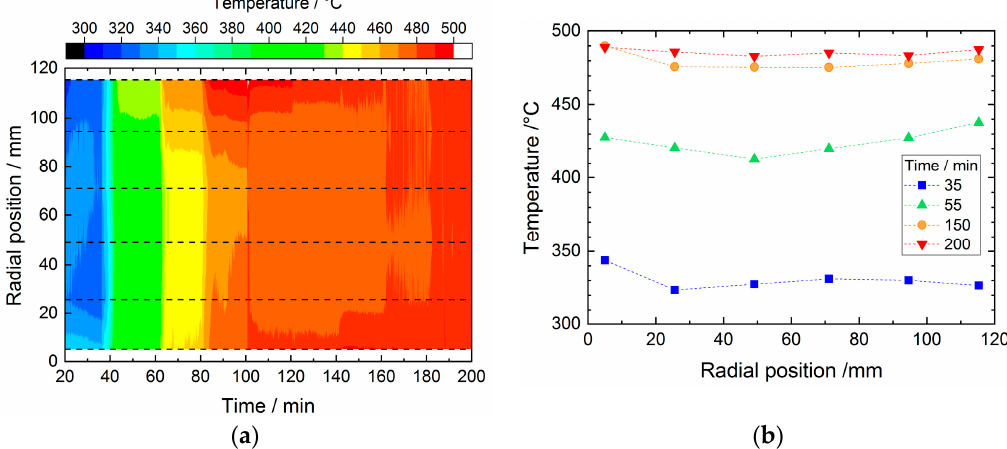
Figure 5. ( a ) Contour plot of the temporal progress of the temperatures in the exhaust-gas diffusor; ( b ) Radial temperature distributions extracted from the contour diagram.